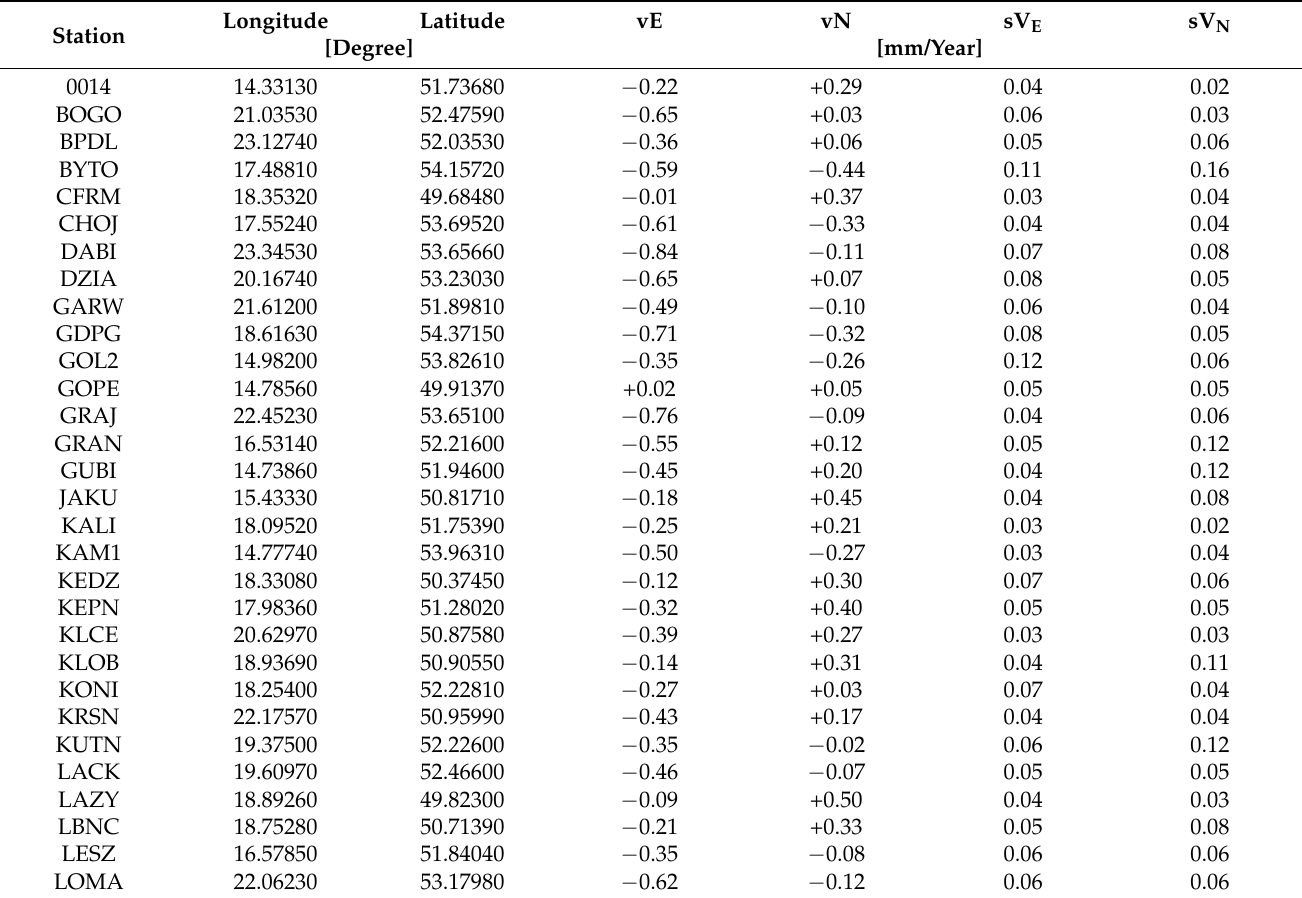
Table A1. The station velocities and their sigmas that have passed both